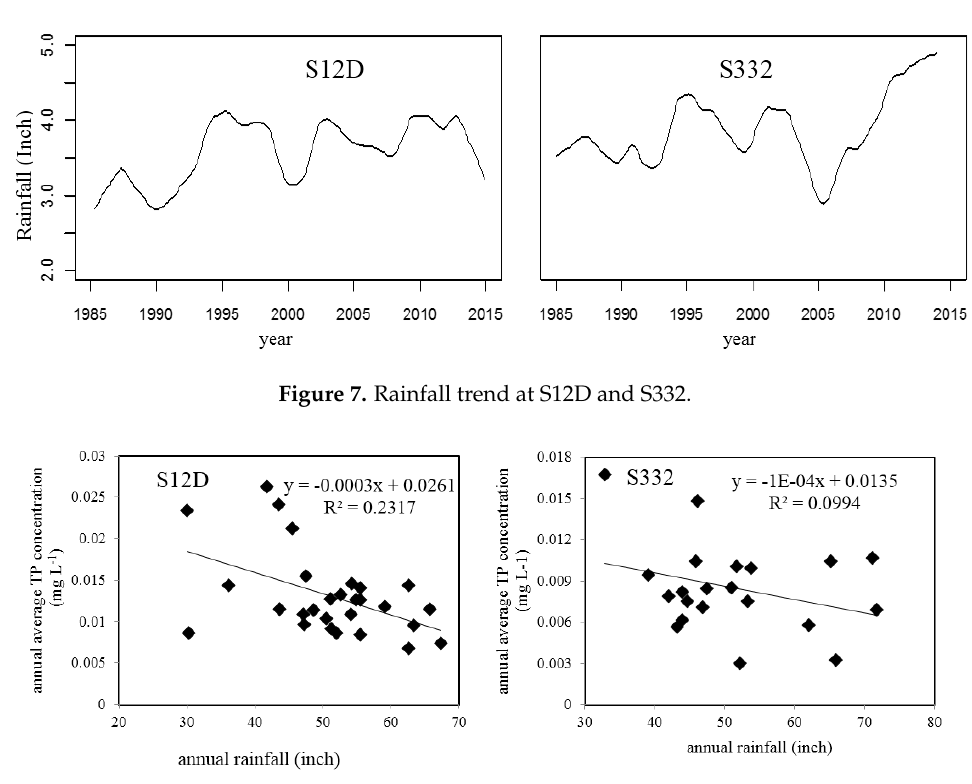
Figure 8. Linear regression between the annual average TP concentration and annual precipitation at S12D and S332. Table 3. Pearson correlation coefficients of water quality variables and monthly rainfall at S12D and S332.